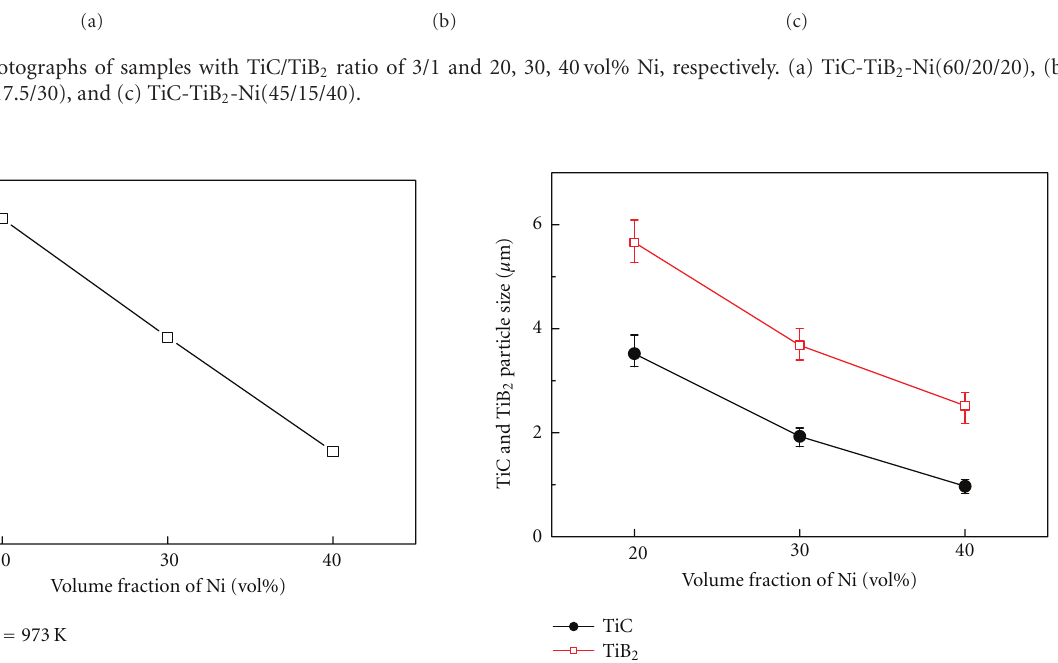
Figure 10: E ff ect of Ni volume fraction on average particle size of samples with a TiC/TiB 2 ratio of 3/1.